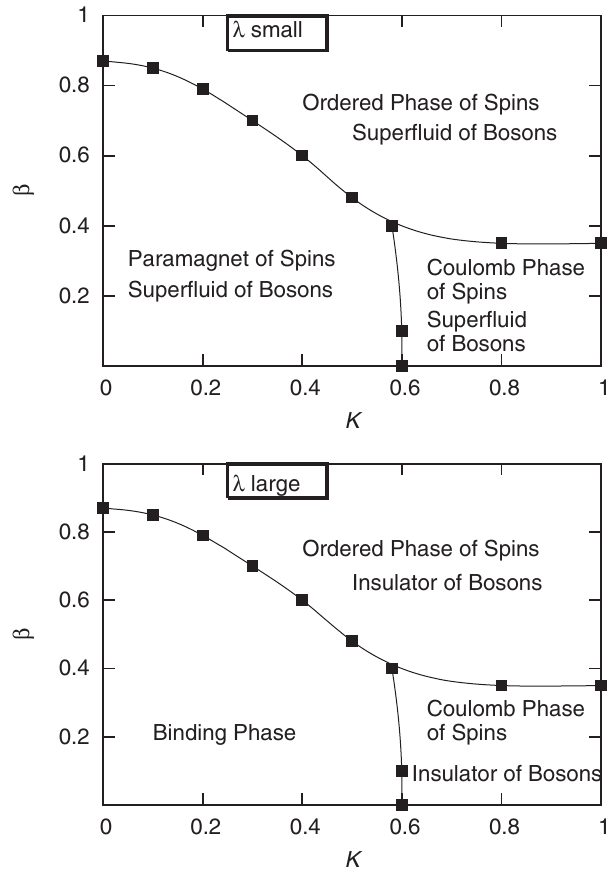
FIG. 7. Bulk phase diagram in the β and K variables for the model defined in Eqs. (1) and (23) where the spins are described by an easy-plane CP 1 model. The top panel shows the phases at small λ , while the bottom panel shows large λ . The locations of the phase boundaries are independent of λ , but the nature of the phases is not. Symbols indicate points where the phase transitions are identified numerically from singularities in the heat capacity. The candidate for the topological phase is the binding phase, which occurs at large λ , small β , and small K